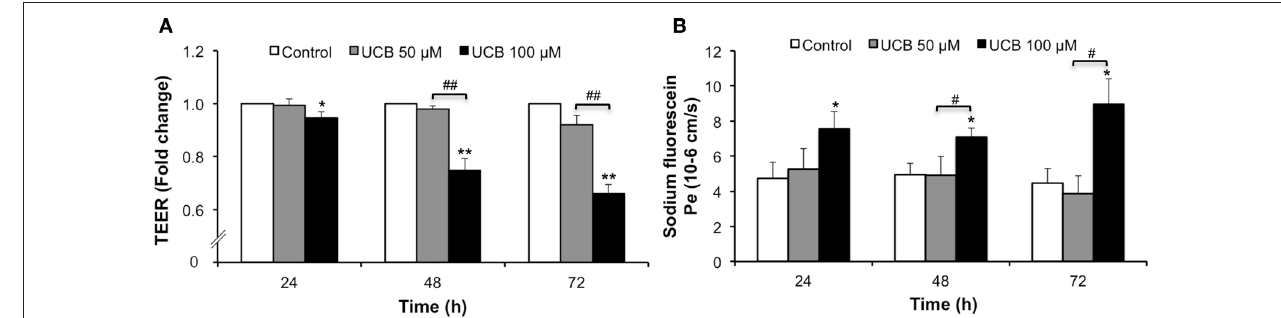
FIGURE 6 | Prolonged interaction of UCB with the HBMEC monolayer decreases TEER and increases paracellular permeability to sodium fluorescein. HBMEC line was incubated without (control) or with 50 or 100 μ M UCB, in the presence of 100 μ M HSA, for the indicated incubation periods. TEER, expressed as fold change from control